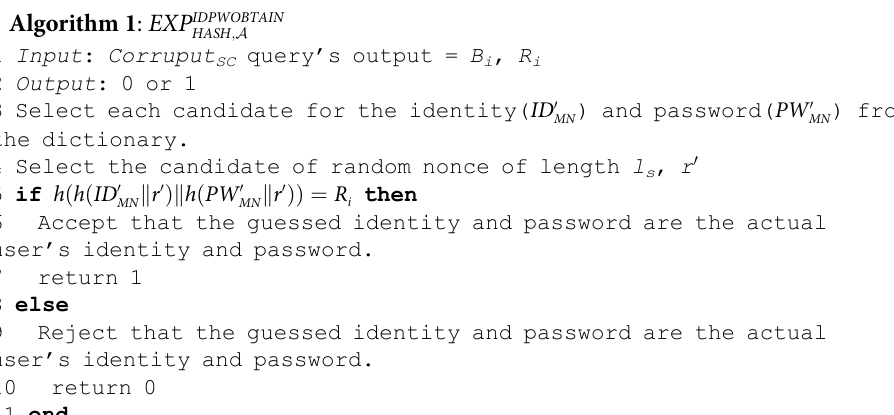
Algorithm 1 : EXP IDPWOBTAIN